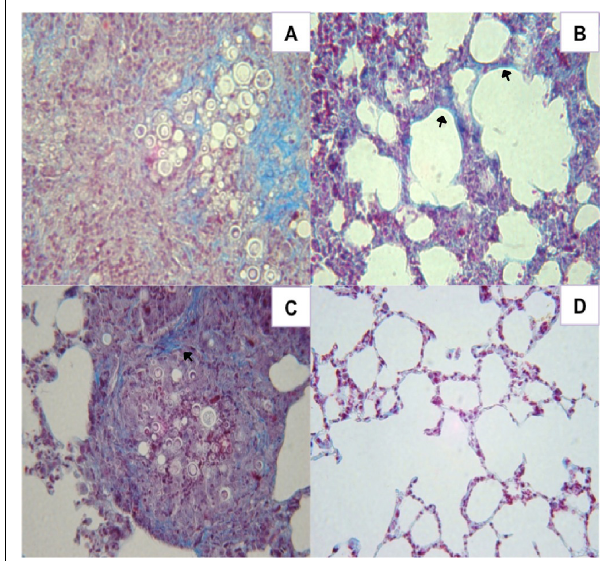
FIGURE 4 | Histological sections of murine lungs from i.t. infected BALB/c mice immunized after 30 days of infection with P10 associated with FliC flagellin, aluminum hydroxide, or cationic lipid. (A) infected, unimmunized control mice, (B) infected and immunized with FliC flagellin plus P10, (C) infected and immunized with aluminum hydroxide plus P10, and (D) infected and immunized with cationic lipid plus P10 after 52 days of infection. Masson’s trichrome staining, × 40 magnification. Blue staining and arrows indicate type I collagen fibers.